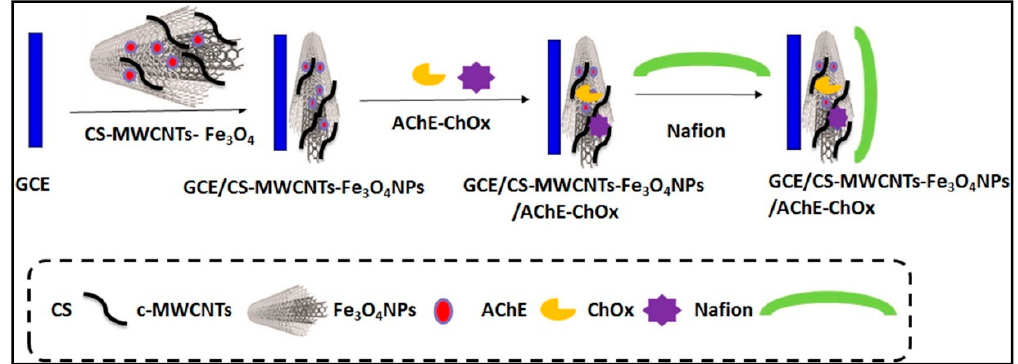
Figure 6. Schematic illustration of the stepwise ACh biosensor fabrication process. Reprinted from [141] with permission of Elsevier.